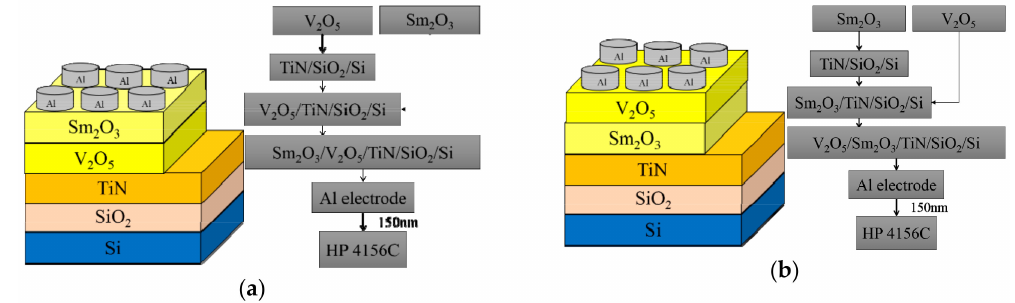
Figure 1. ( a ) The structure and deposition process of the Al / Sm 2 O 3 / V 2 O 5 / TiN / SiO 2 / Si device. ( b ) The structure and deposition process of the Al / V 2 O 5 / Sm 2 O 3 / TiN / SiO 2 / Si